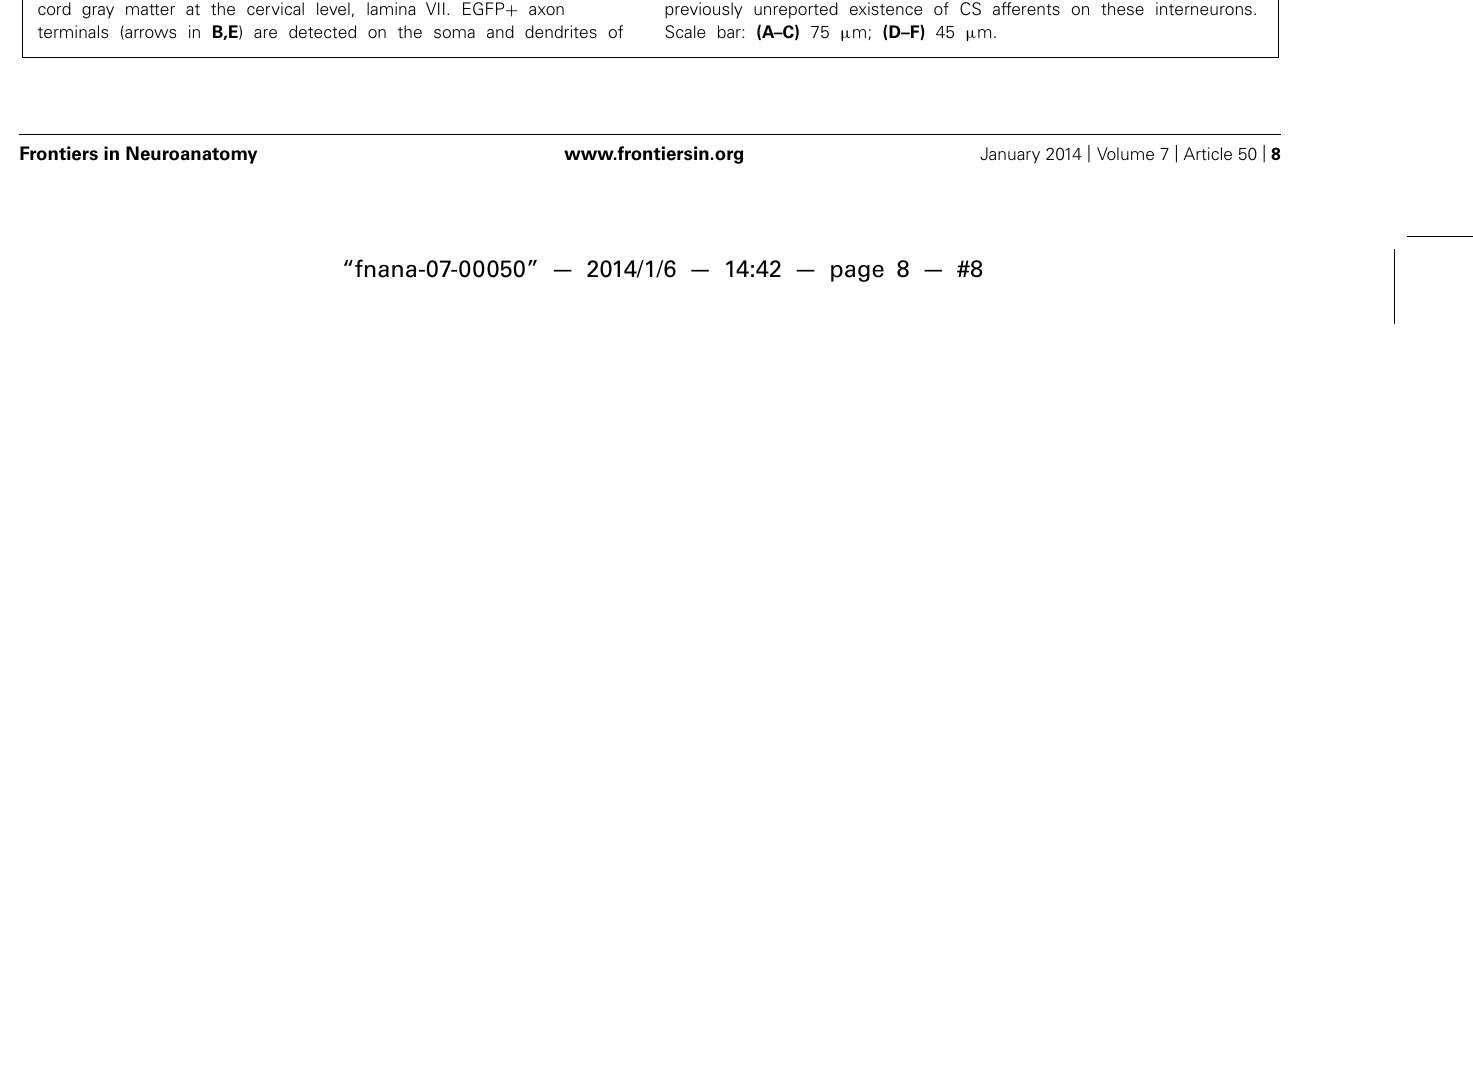
calbindin (CaBP) immunoreactive cell bodies (A,D) likely corresponding to Renshaw neurons. Overlay in (C,F) . This finding suggests the previously unreported existence of CS afferents on these interneurons. Scale bar: (A–C) 75 μ m; (D–F) 45 μ